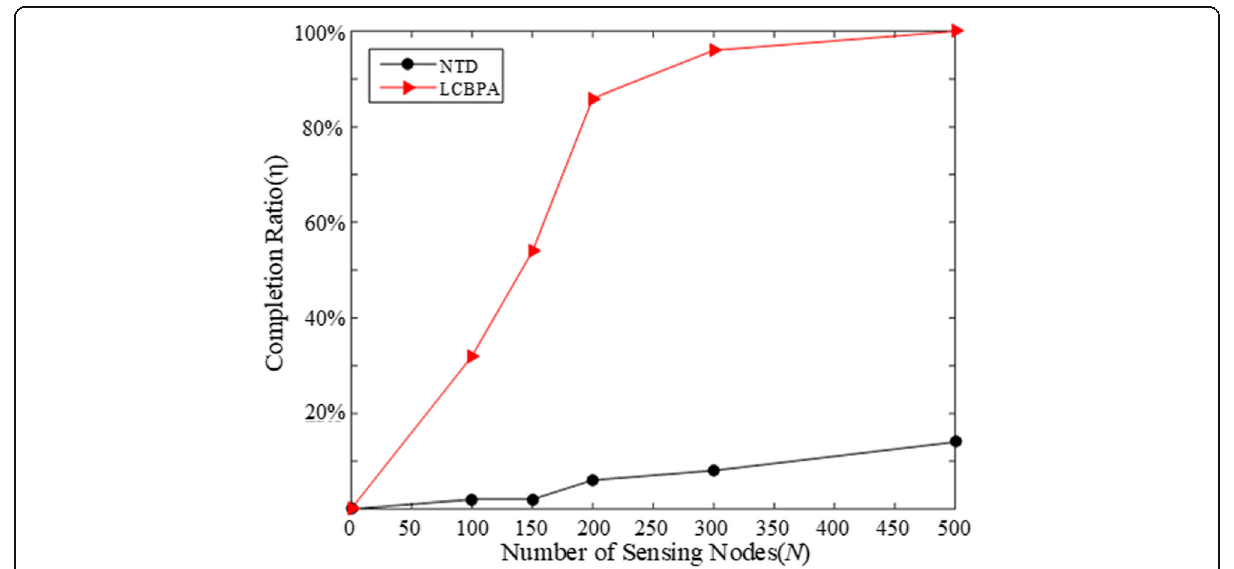
Fig. 2 Task completion ratio comparison of LCBPA and NTD under different network scale when k = 20, α =